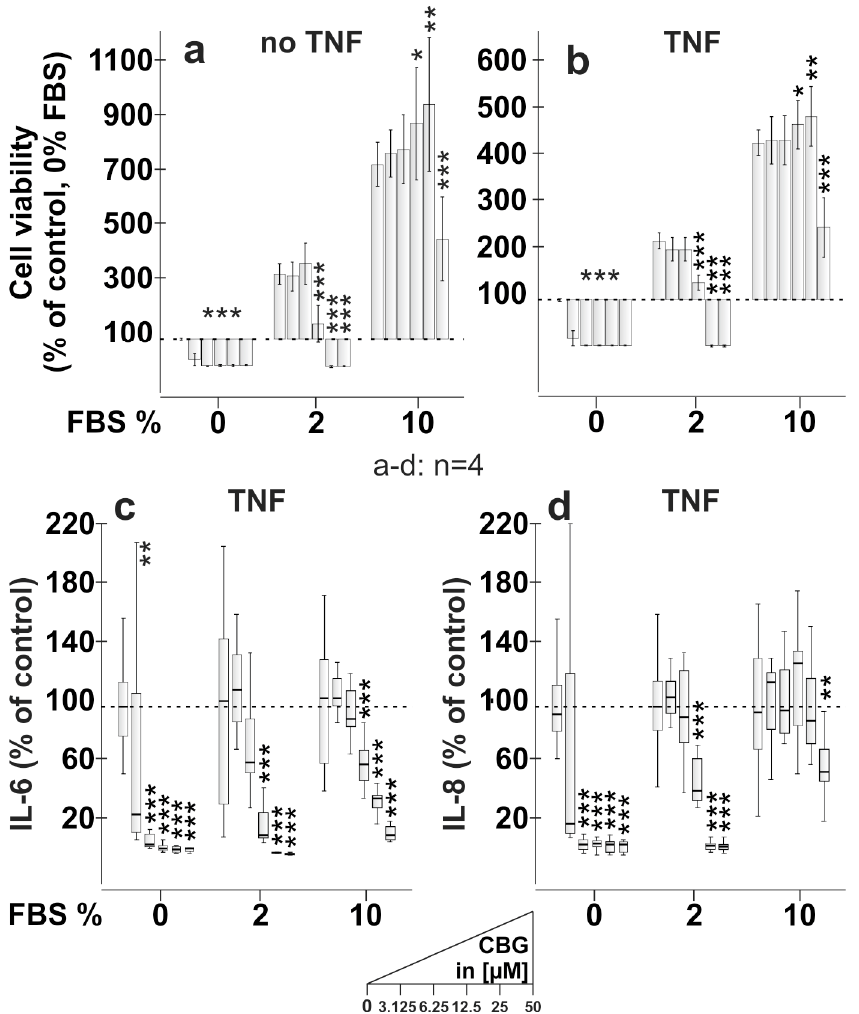
Figure 3. Influence of CBG on cell viability, IL-6 and IL-8 production of RASF . ( a , b ) Cell viability of RASF after stimulation with CBG for 24 h, either with ( b ) or without ( a ) 72 h pre-treatment with TNF [10 ng/mL] in culture medium containing 0%, 2% or 10% FBS. The dotted line at 100% represents the control. All values were normalized to the control at 0% FBS ( a , b ). ( c , d ) Reduction of TNF-induced IL-6 ( c ) and IL-8 ( d ) production by CBG in culture medium containing 0%, 2% or 10% FBS. The dotted line represents the control. Control IL-6 levels were 4.1 ng/mL ± 3.1 ng/mL (0% FBS), 23.5 ng/mL ± 24.6 ng/mL (2% FBS) and 18.6 ng/mL ± 12.4 ng/mL (10% FBS). Control IL-8 levels were 14.4 ng/mL ± 5.0 ng/mL (0% FBS), 38.9 ng/mL ± 16.1 ng/mL (2% FBS) and 44.0 ng/mL ± 26.7 ng/mL (10% FBS). *** p < 0.001, ** p < 0.01, * p < 0.05 for differences between concentrations of CBG vs. control. Block design ANOVA with Dunnett’s post hoc test was used for comparisons. The box plots of each series (0, 2 and 10% FBS) represent 0 µM, 3.125 µM, 6.25 µM, 12.5 µM, 25 µM and 50 µM CBG.